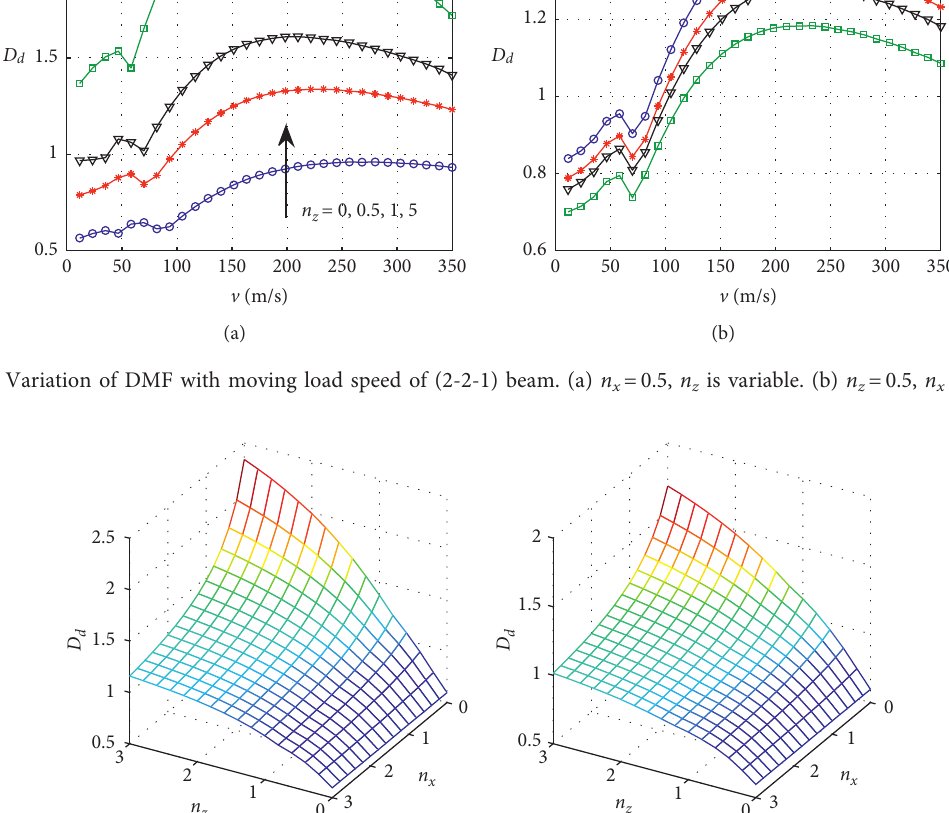
Figure 8: Variation of DMF with material grading indexes of BFGSW beam for v � 50m/s. (a) (2-1-2) beam. (b) (2-2-1) beam.